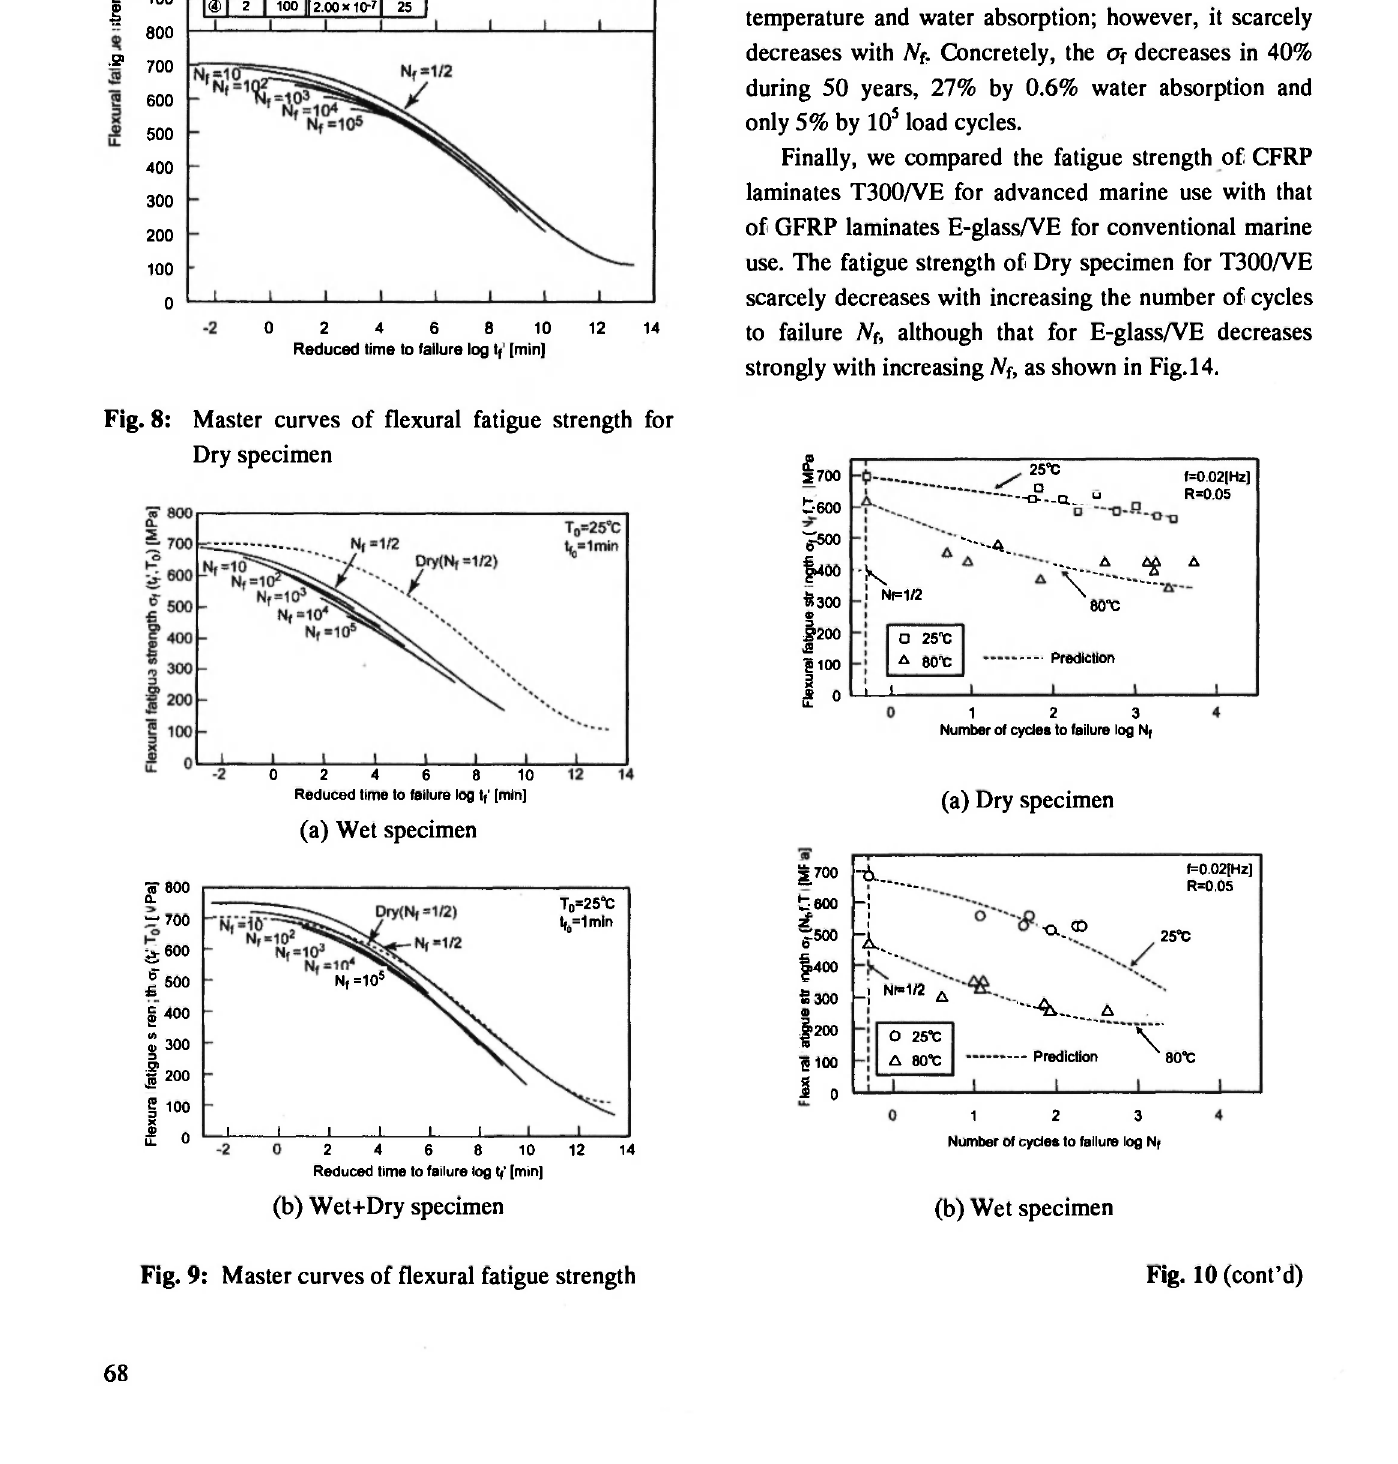
Master curves of flexural fatigue strength for